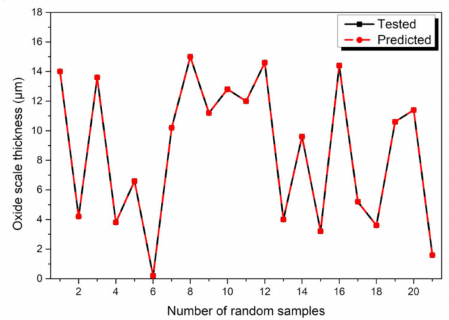
Figure 9. The testing data and the prediction results of the oxide scale thickness of PCA-PSO-ELM training